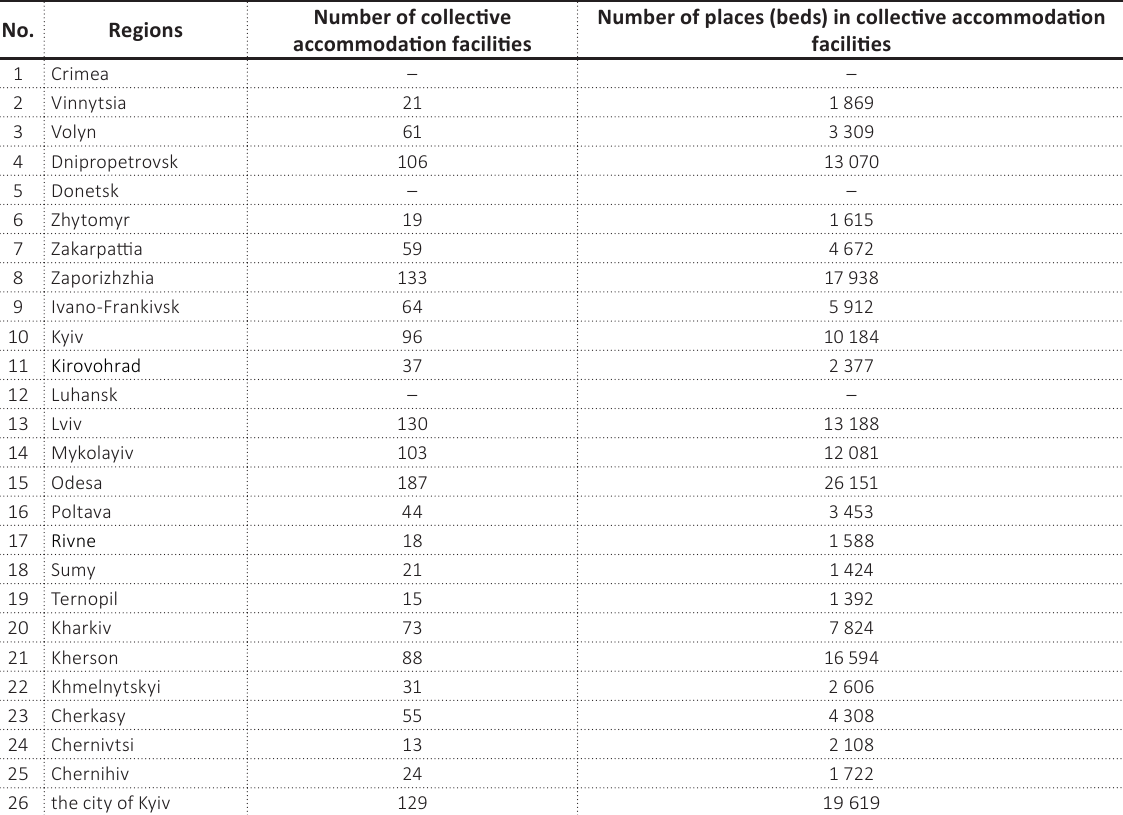
Source: National Tourism Organization of Ukraine (2021).